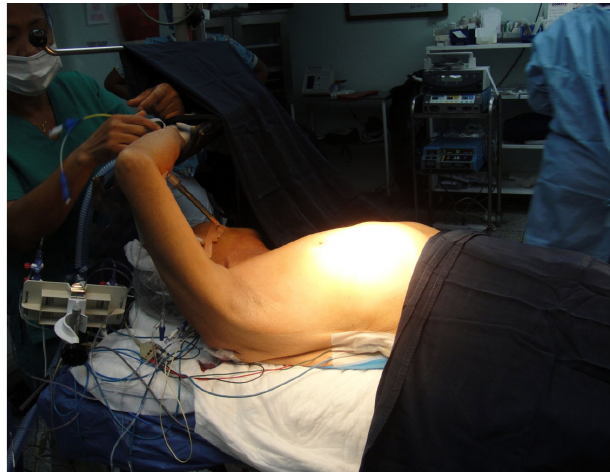
Fig. 1 - Patient position - the patient is positioned with the right arm elevated at approximately 30° toward left